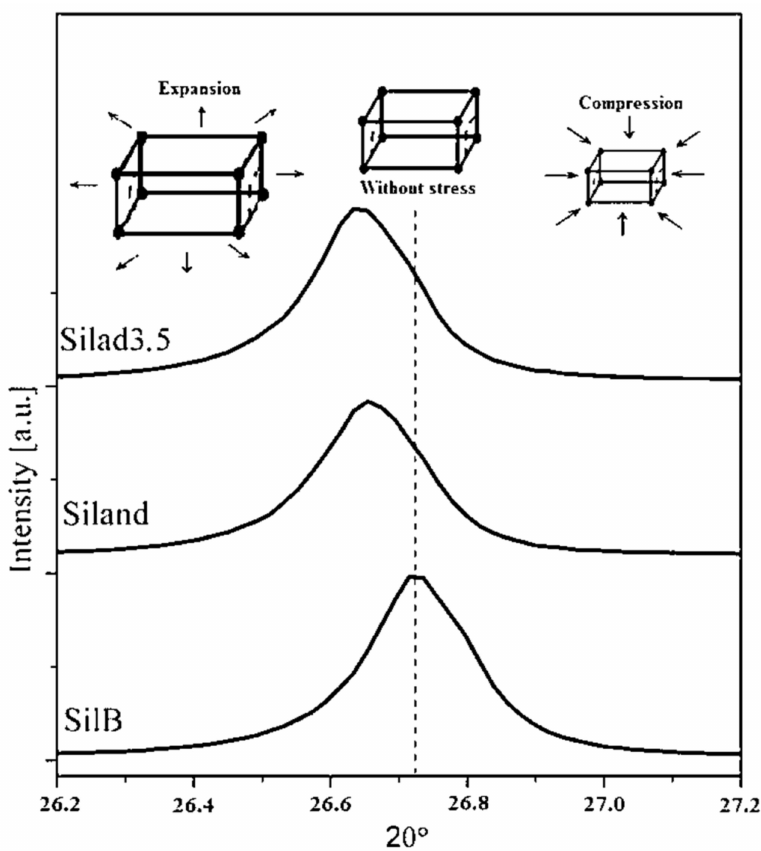
Figure 10. XRD (101) main peak of SilB, Siland, and Silad3.5 samples. The presence of silanols and of nano-fibrous surface presents a double advantage for the improvement of the interaction at the interfaces between SiO 2 and certain organic surfaces such as polymers and/or asphalt for example.